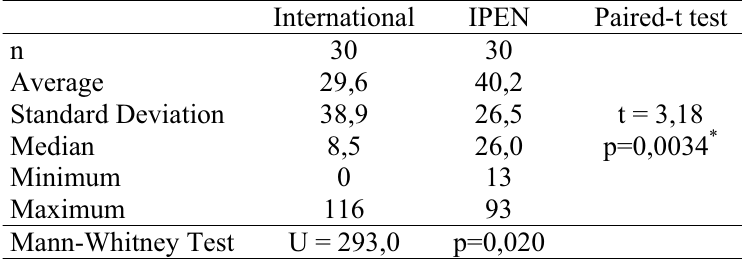
TABLE 1 – Comparison between the values of gamma radiation reading using the international and the IPEN intraoperatory gamma detection equipments of